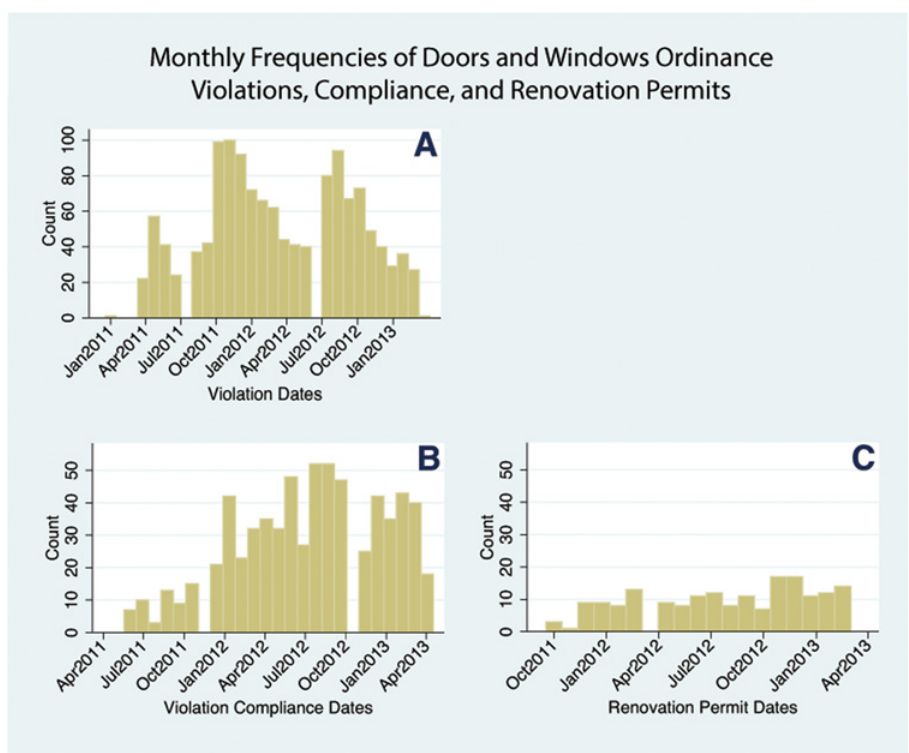
Fig 2. Monthly Frequencies of Violation Citations (A), Violation Compliances (B) and Renovation Permits (C) between January 2011 and May 2013.